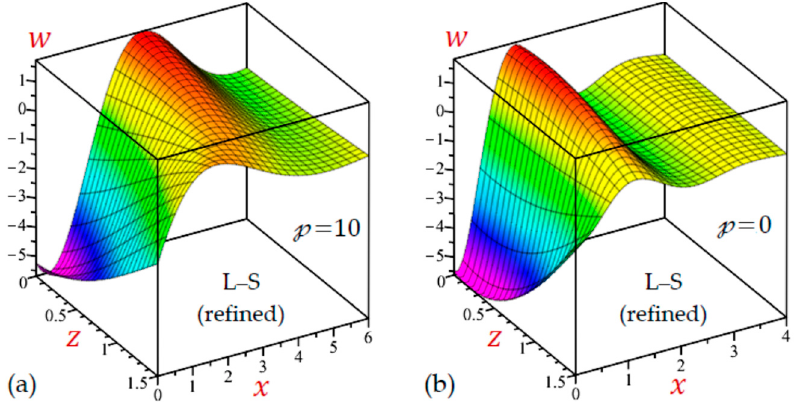
Figure 18. 3D distributions of the transverse displacement w of the rotating half-space: ( a ) with initial pressure ( (cid:112) = 10) and ( b ) without initial pressure ( (cid:112) = 0) using the refined L–S generalized theory.